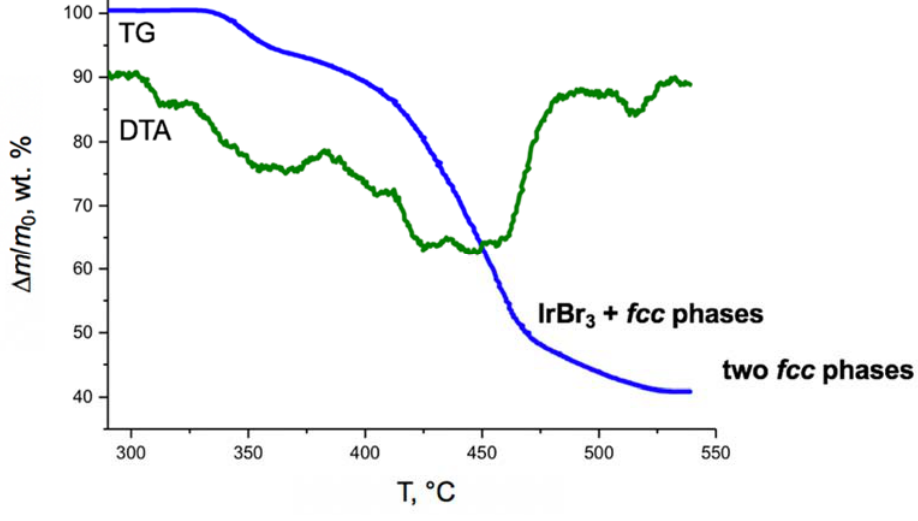
Figure 1. Thermal gravimetry (TG) and differential thermal analysis (DTA) curves for [Ir(NH 3 ) 5 Cl][PtBr 6 ] in helium flow (closed Pt crucible, 5 K/min, 150